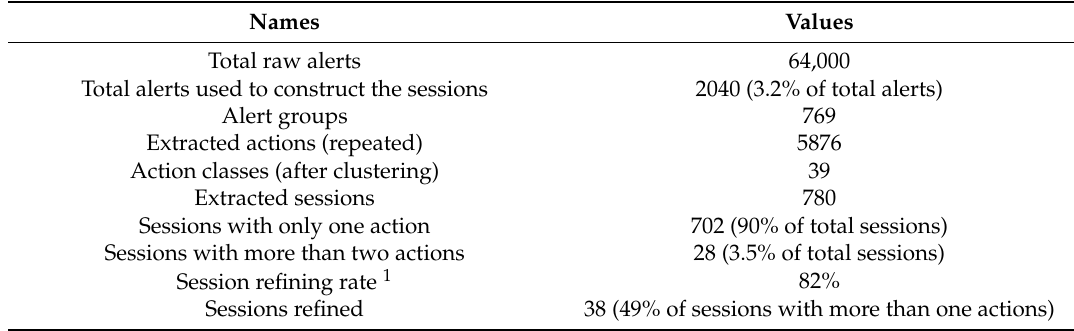
Table 2. Statistical results of the data